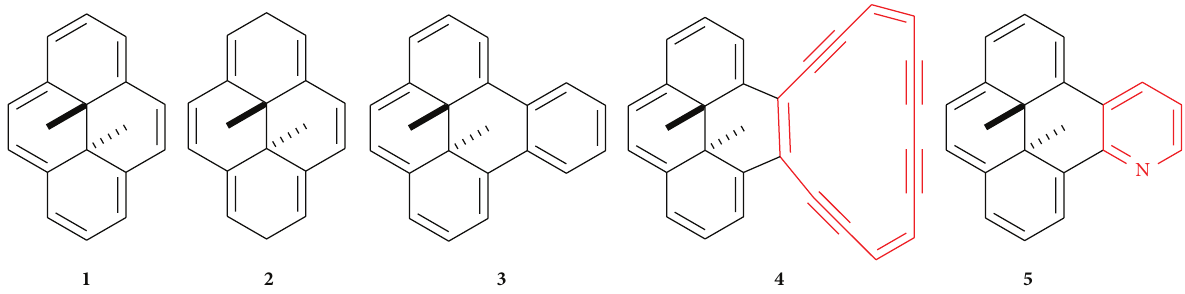
Figure 1: A few aromatic and nonaromatic